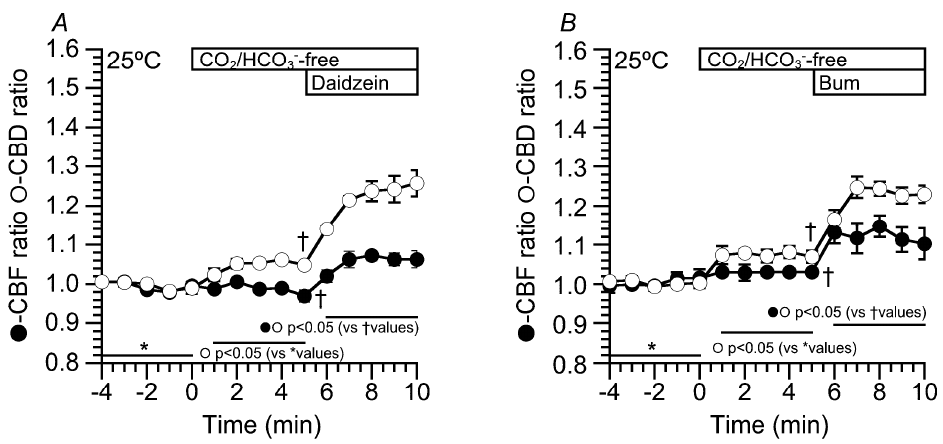
Figure 10. Effects of daidzein and bumetanide on CBD and CBF at 25 °C. Experiments were carried out under the CO 2 /HCO 3 − -free condition. ( A ) Daidzein (100 µM). Stimulation with daidzein increased both CBD and CBF. ( B ) Bumetanide (Bum, 20 µM). The addition of bumetanide also increased CBD and CBF.